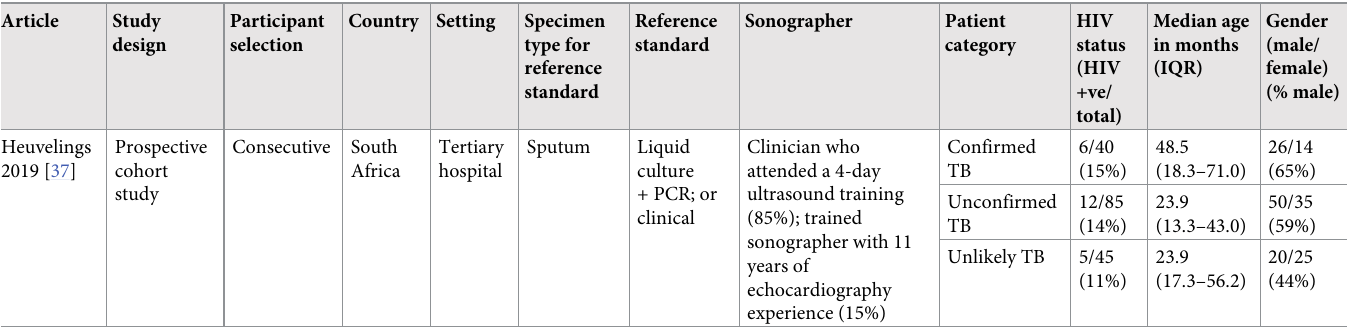
Table 2. Individual study characteristics for studies in children.